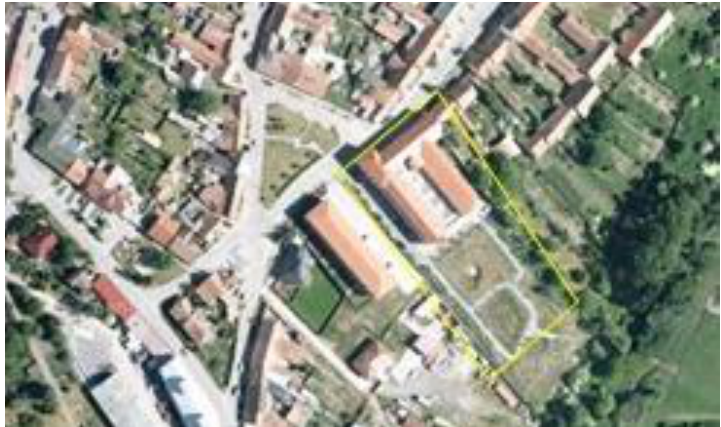
Figure 7. Aerial view of a new social care home for elderly people with a new park in 2015. Source: [60].